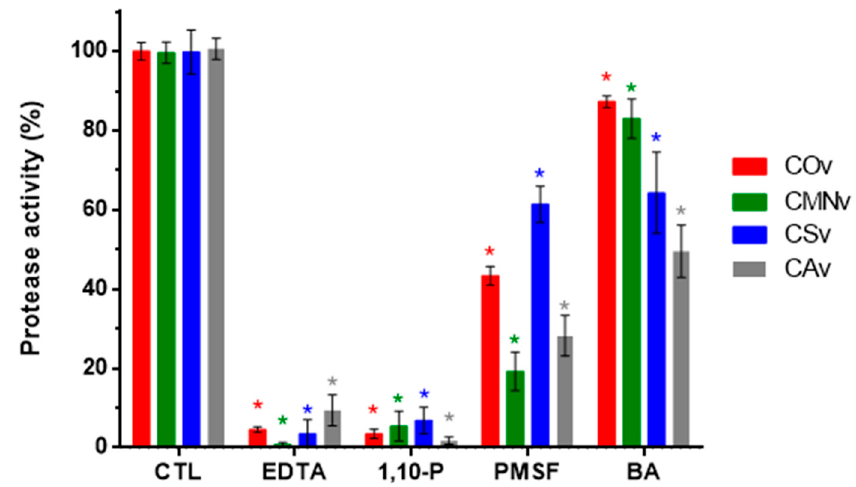
Figure 2. Inhibitor modulation of protease activity for C. ornatus (COv), C. m. nigrescens (CMNv), C. scutulatus (CSv), and C. atrox (CAv). 10 µg of each venom were preincubated without inhibitor (control, CTL) or with 5 mM of metalloprotease inhibitors (EDTA and 1,10-P) and serine protease inhibitors (PMSF and BA) for 10 min at 37 °C before substrate addition. Enzymatic activity is expressed in protease activity percentage in comparison to CTL. Data are presented as the mean of at least three independent experiments with its respective standard error, statistically significant difference ( p < 0.05) with respect to control for each venom is represented with an asterisk (*).